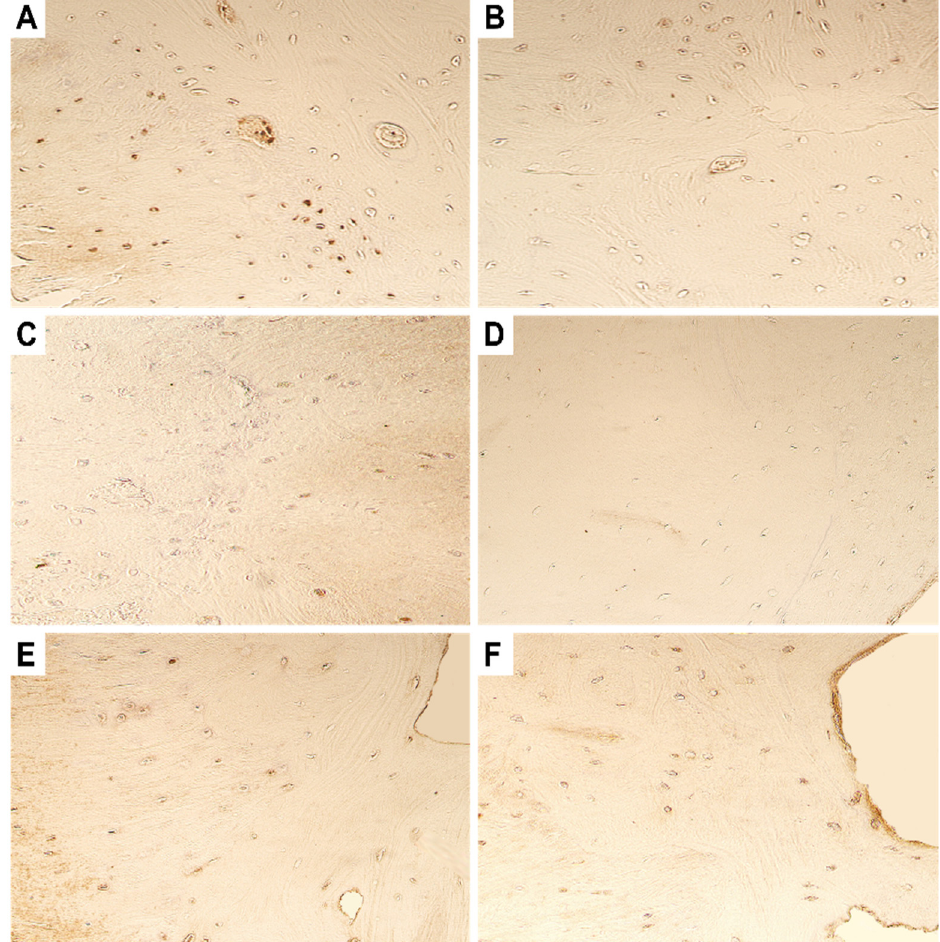
Figure 6. Microphotographs of the fibrous cartilage and ankylotic bone tissue immunostained with RUNX-2, WNT-1, and WNT-3a. ( A ) Moderate number of RUNX-2-positive chondrocytes and osteocytes can be noted in the primary surgery tissue. ( B ) In the repeated surgery tissue, only few RUNX-2-positive cells can be seen. ( C ) Few WNT-1 osteocytes can be visualized in the bony tissue from primary surgery. ( D ) No WNT-1-positive cells could be seen in the repeated surgery material. ( E ) Few WNT-3a-positive chondrocytes and osteocytes in the primary surgery material can be noted. ( F ) In the repeated surgery tissue, only few WNT-3a-positive osteocytes were seen. Original magnification, 250×.